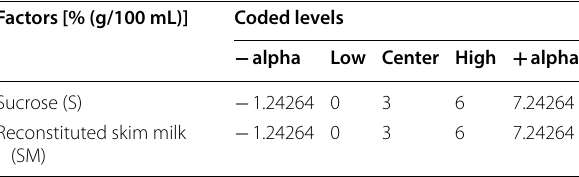
skim milk for central composite experimental design Factors [% (g/100